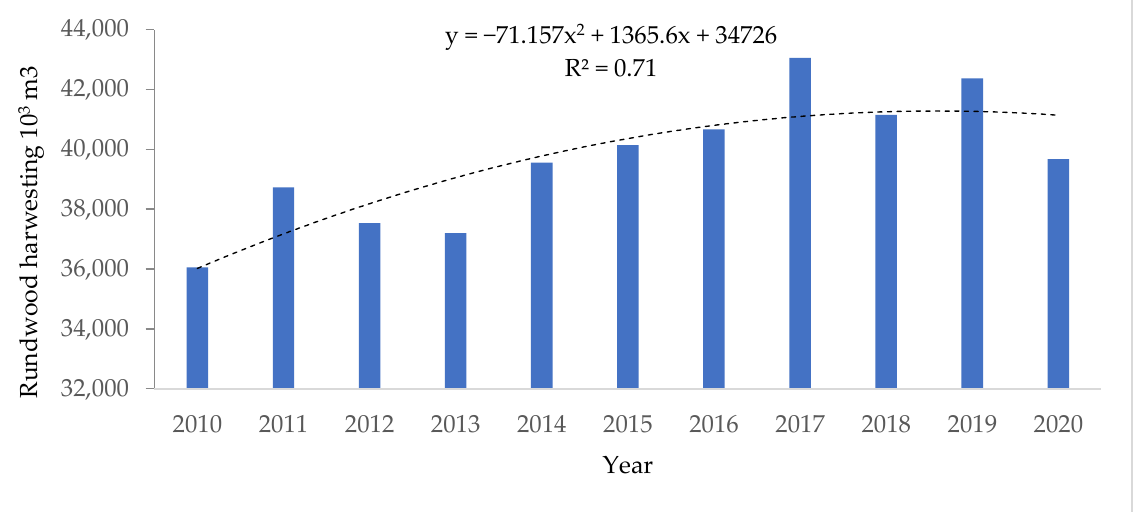
Figure 2. The amount of round wood processed in Poland. Source: own elaboration. Table 4. Types and estimated quantity of generated wood by-products.